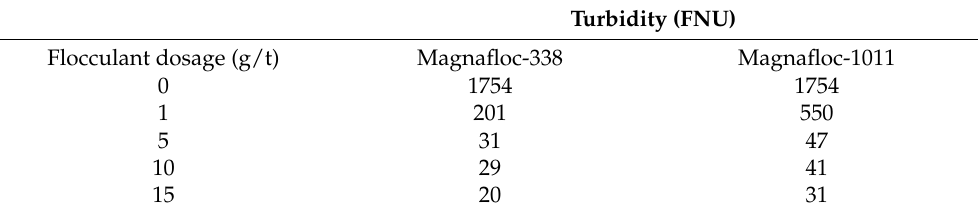
Table 7. Turbidity in the 2 best flocculants